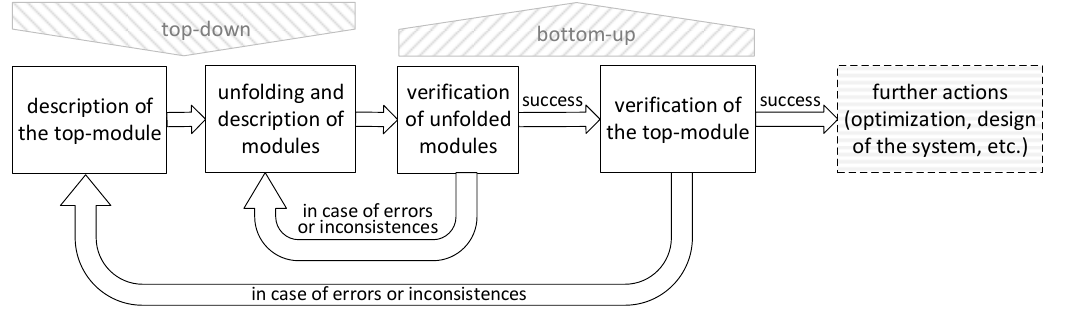
Figure 3. A scheme of the proposed modelling methodology.